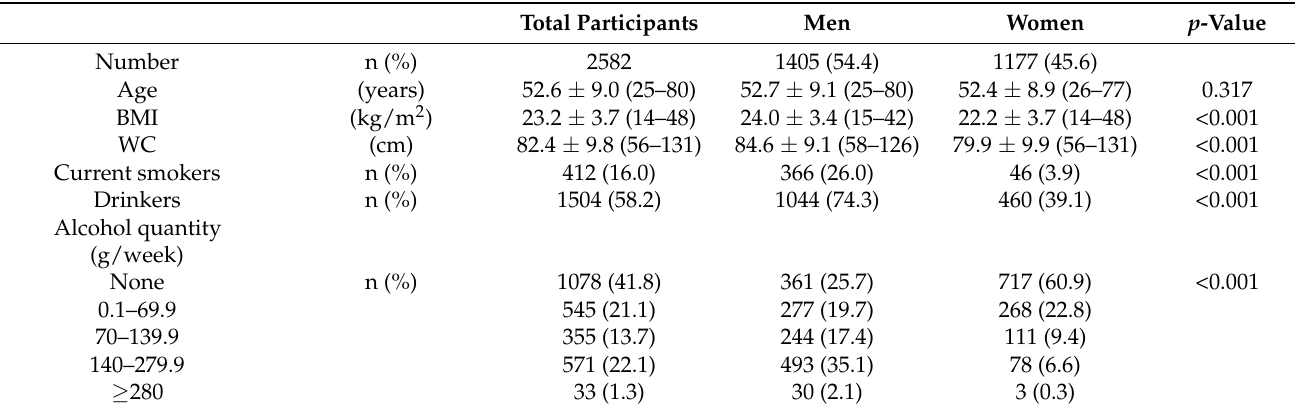
Table 1. Baseline characteristics according to